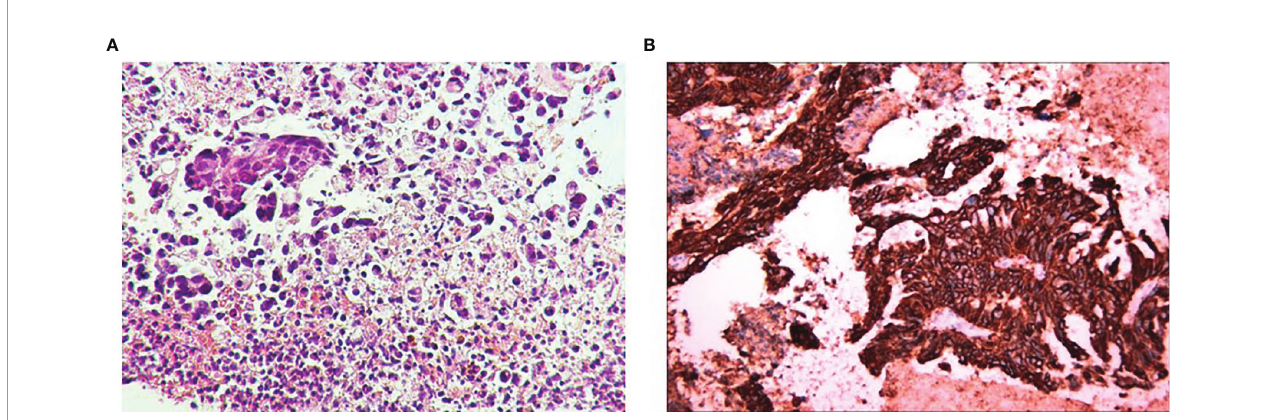
FIGURE 1 | Hematoxylin-Eosin staining (A) and immunohistochemical staining of HER2 expression (B)